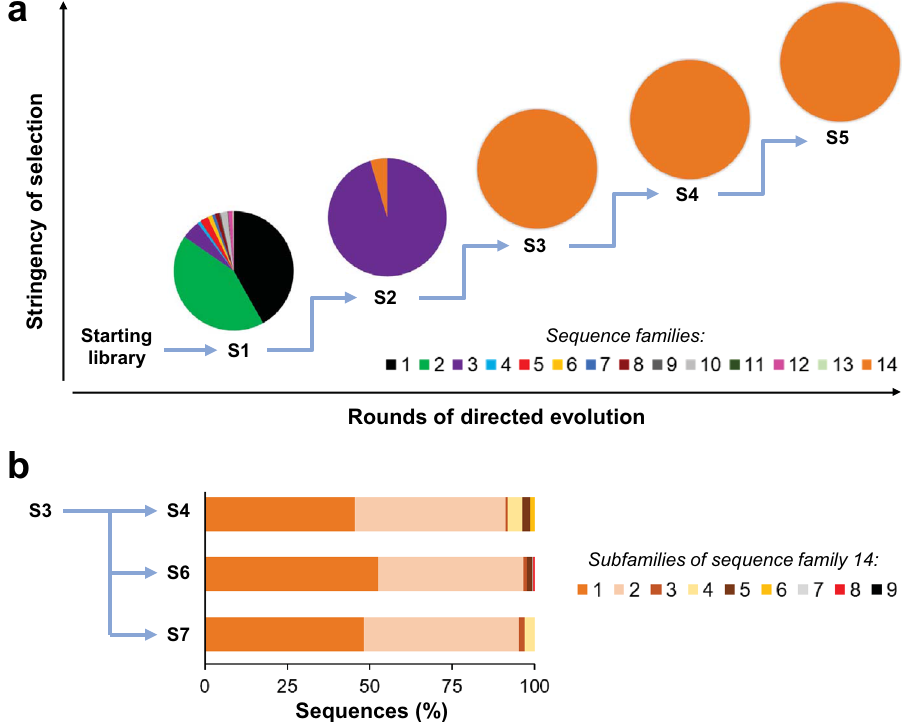
Figure 4. Analysis of nine sequence populations from a protein directed evolution campaign. ( a ) The samples S1-S5 represent protein populations from progressive generations of laboratory evolution performed with stepwise increases in selection pressure. The pie charts for each sample illustrate the distribution of different sequence families within that population. Each family is shown in a different colour and the size of the segment represents the abundance of that family in the sample population. The black, green and purple segments in samples S1 and S2 represent sequence families 1, 2 and 3, respectively. Sequence family 14 is depicted in orange and dominates the sample S3 and all following generations. ( b ) Analysis of sequence distribution at subfamily level for samples S4, S6, and S7. One round of selection was carried out on the same population of protein variants, yet using three different selection conditions resulting in the three sample populations S4, S6 and S7. While all sequences in those samples belonged to sequence family 14, subfamilies were discerned within each of the populations as shown by different shades of orange. These subfamilies constitute either a specific point mutation or a cluster of mutations. The abundance of different subfamilies in a population is represented in the graph. Samples S8 and S9 were experimental control populations and are not shown